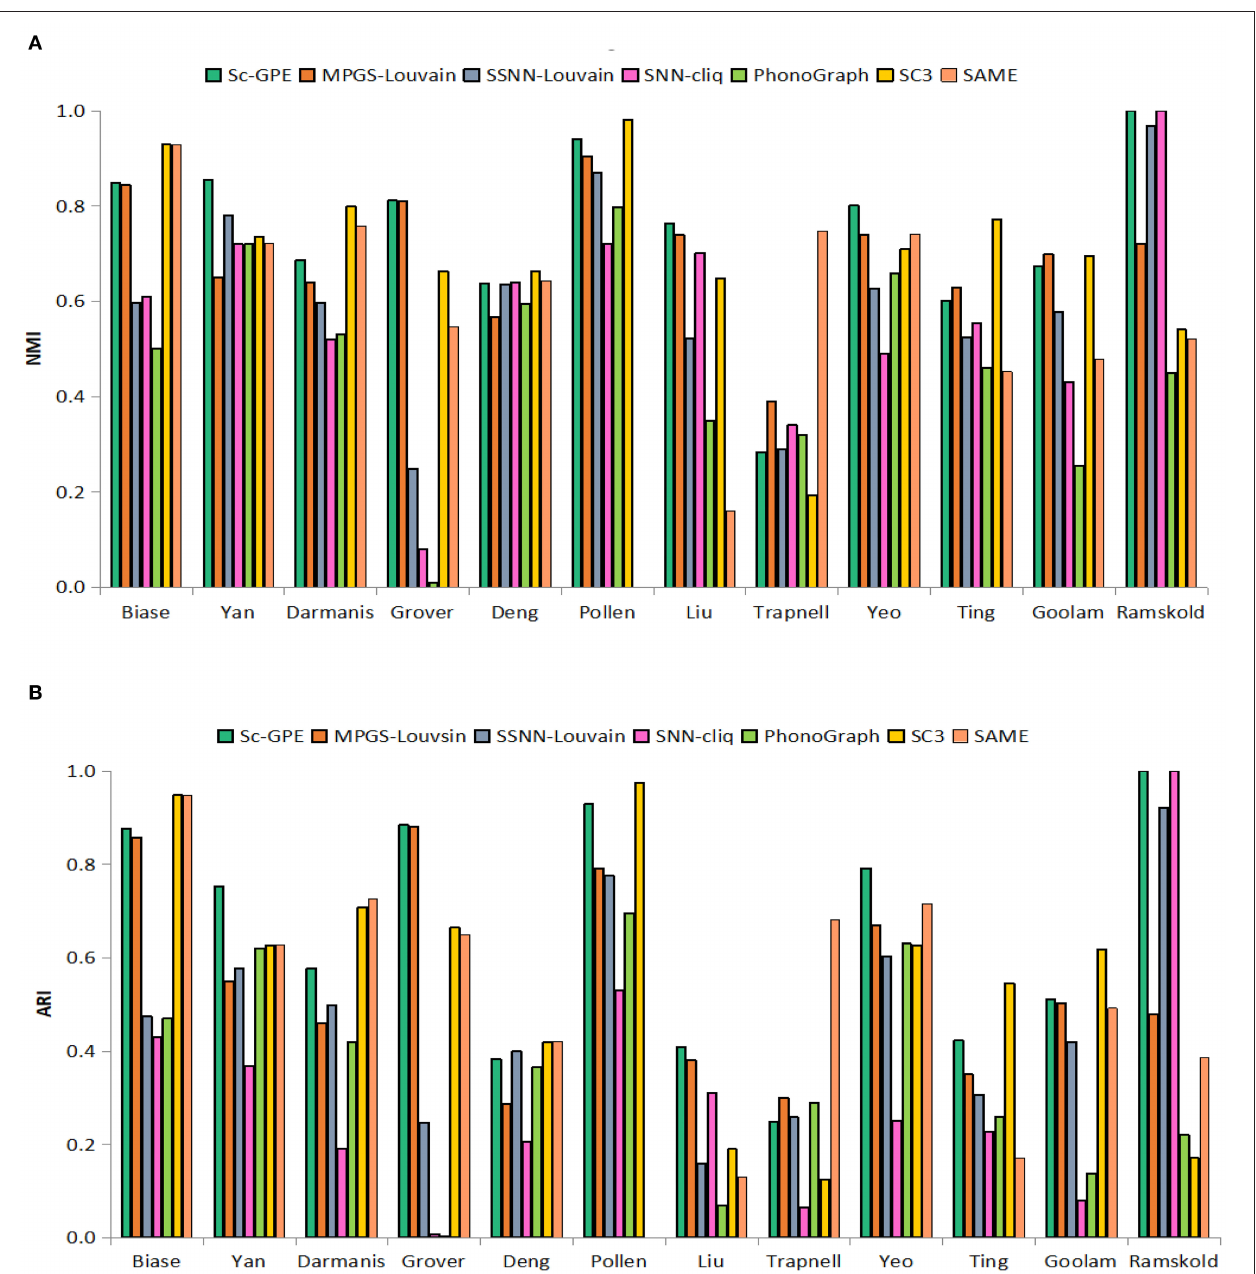
FIGURE 3 | The performance of Sc-GPE, MPGS-Louvain, SSNN-Louvain, SSNN-cliq, PhenoGraph, and SC3. (A) NMI; (B) ARI.